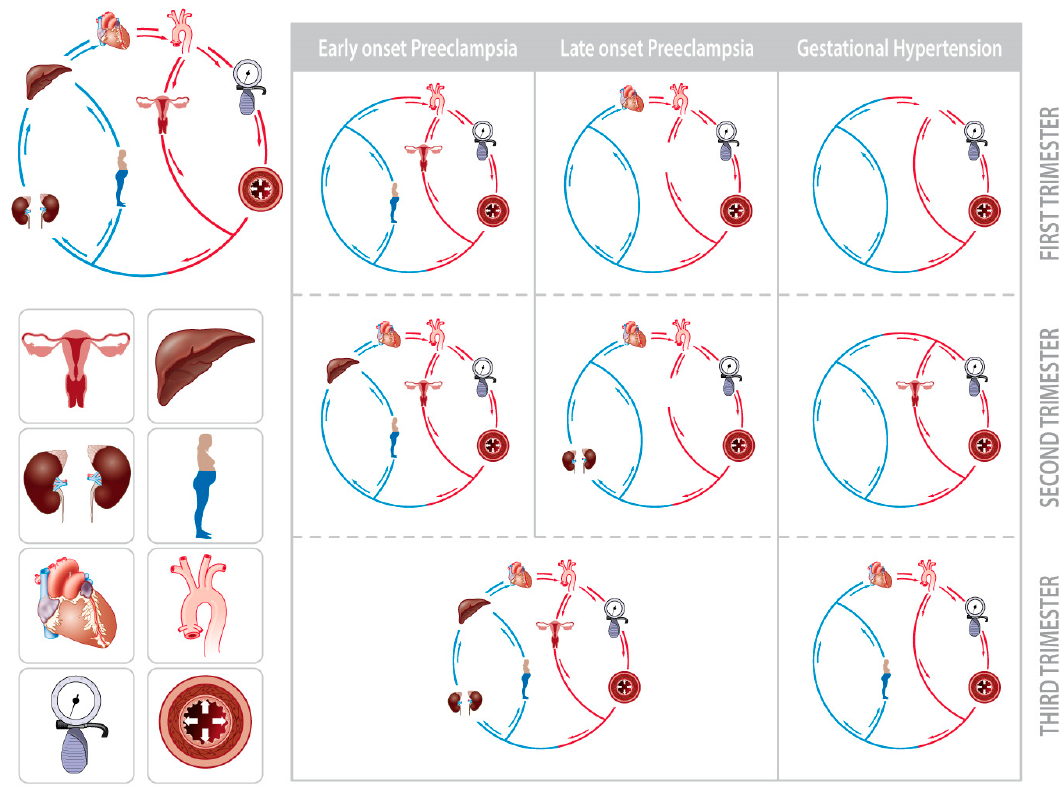
Figure 3. Schematic presentation of the gradual deterioration of circulatory dysfunction from the first to third trimester in early-onset preeclampsia, late-onset preeclampsia, and gestational hypertension (adapted from [114]). The circulation is presented as a closed circuit, with interdependently functioning components. The depicted icons in the circuit represent the sites / organs where abnormal hemodynamic characteristics are measured using noninvasive impedance cardiography, bioimpedence spectrum analysis, and combined ECG / Doppler ultrasonography [114]. Early gestational dysfunctions in the first trimester gradually increase throughout the course of the pregnancy, and this co-exists with the expansion of body water volumes [111]. The final end stage, defined as early-onset preeclampsia, late-onset preeclampsia, or gestational hypertension, depends on the type of hemodynamic dysfunction already present in the first trimester. Note that abnormal Doppler characteristics of the hepatic and renal interlobar veins are observed in preeclampsia but not in gestational hypertension.